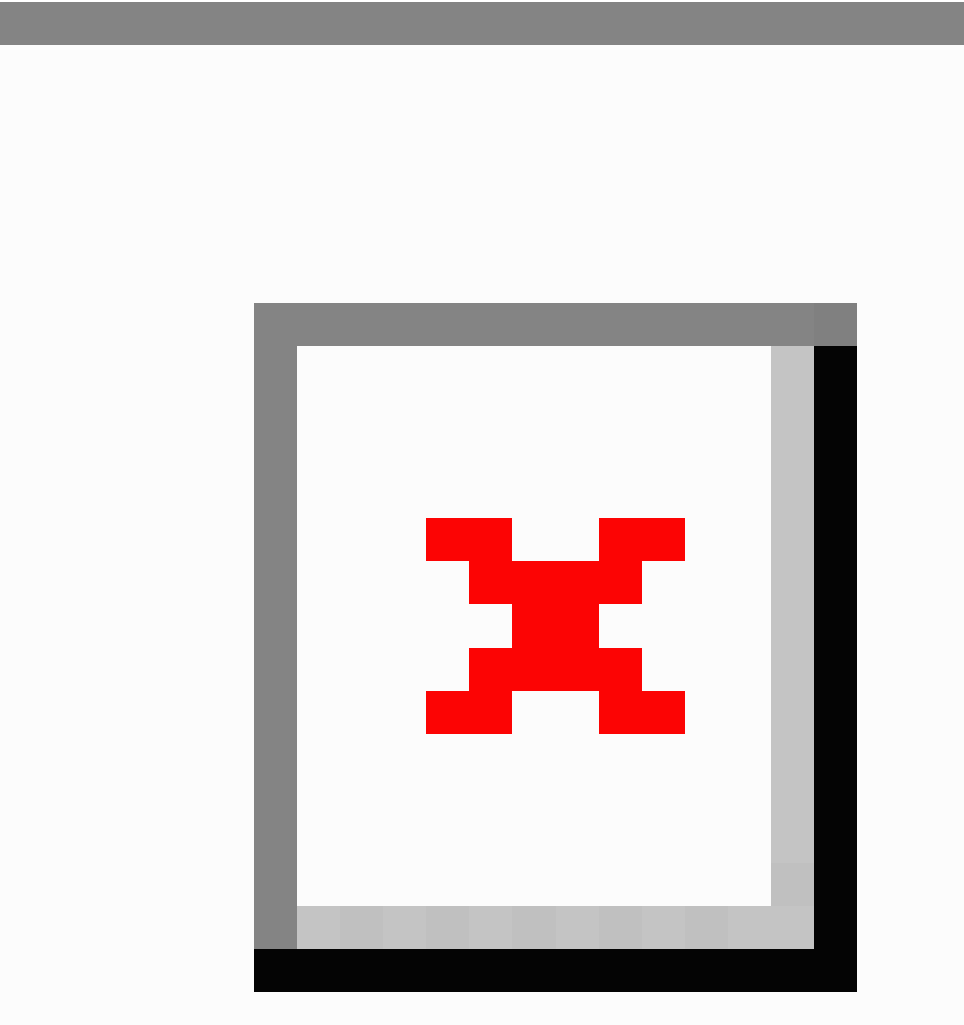
Figure 2. Independent predictors of overall patient satisfaction and recommendations after